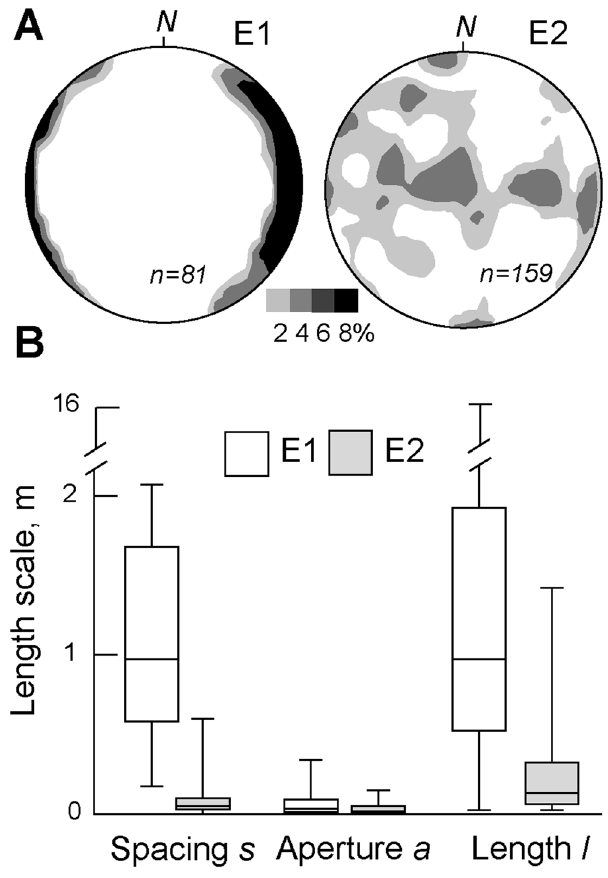
Figure 2. ( A ) Density plot (2–8%; equal area Schmidt net, lower hemisphere) of poles to vein walls in the E1 and E2 alteration zones. ( B ) Box plot summarizing the variations of the geometric parameters of E1 and E2 veins. Density plots were generated with GEOrient © software by Rod Holcombe (http://www.holcombe.net.au/ software/georient.html, academic license).